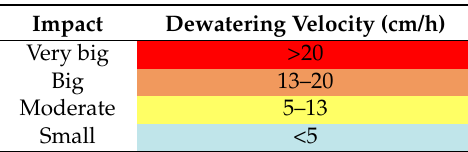
Table 1. Dewatering velocity rates (with color code) to assess the impact of hydropeaking [5].